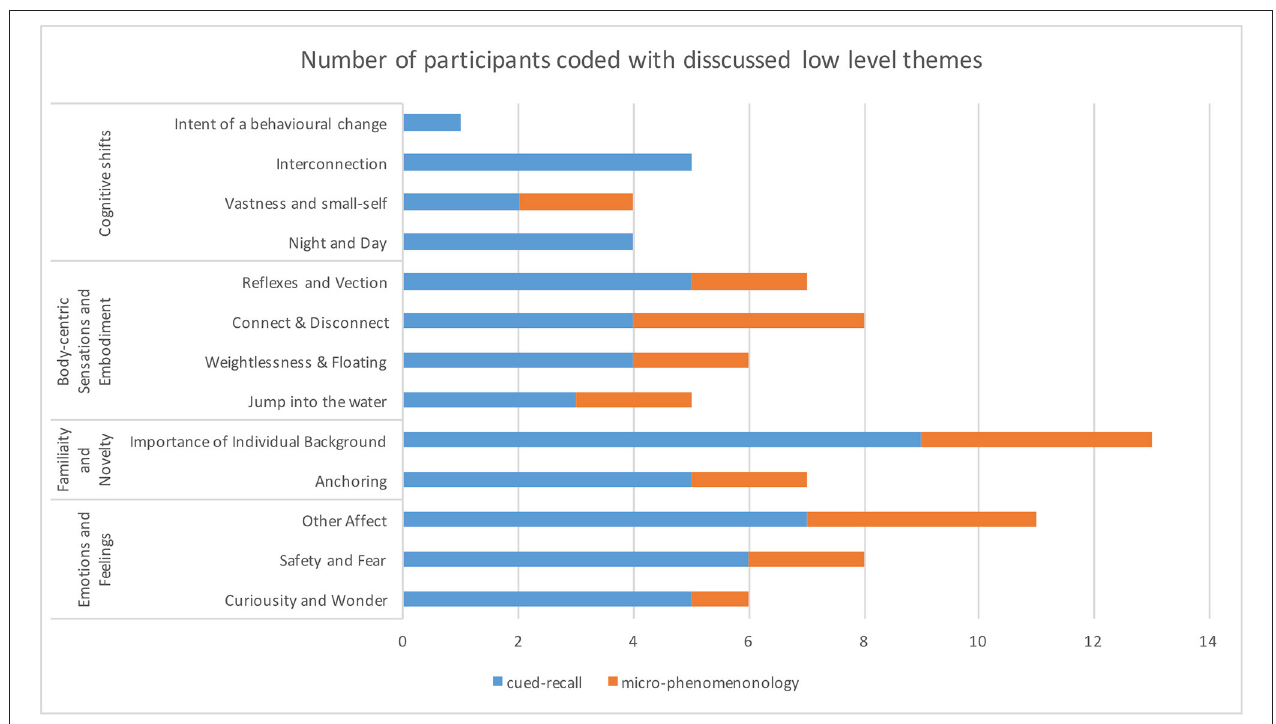
FIGURE 6 | The number of participants (total = 13), that had statements coded with themes reported in this